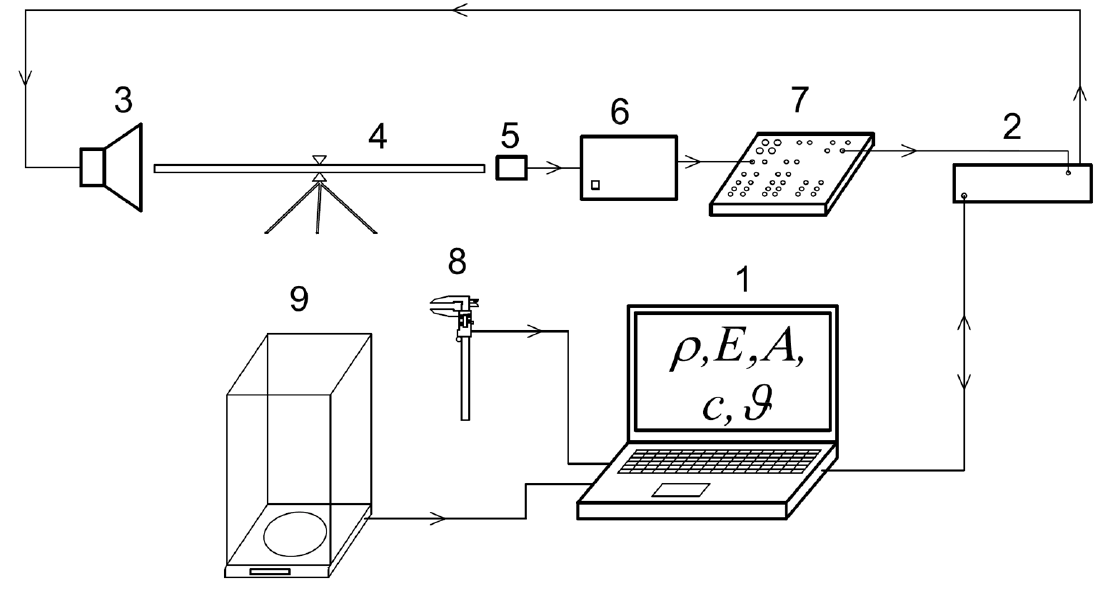
Figure 2. Measuring device MEARFA [36].